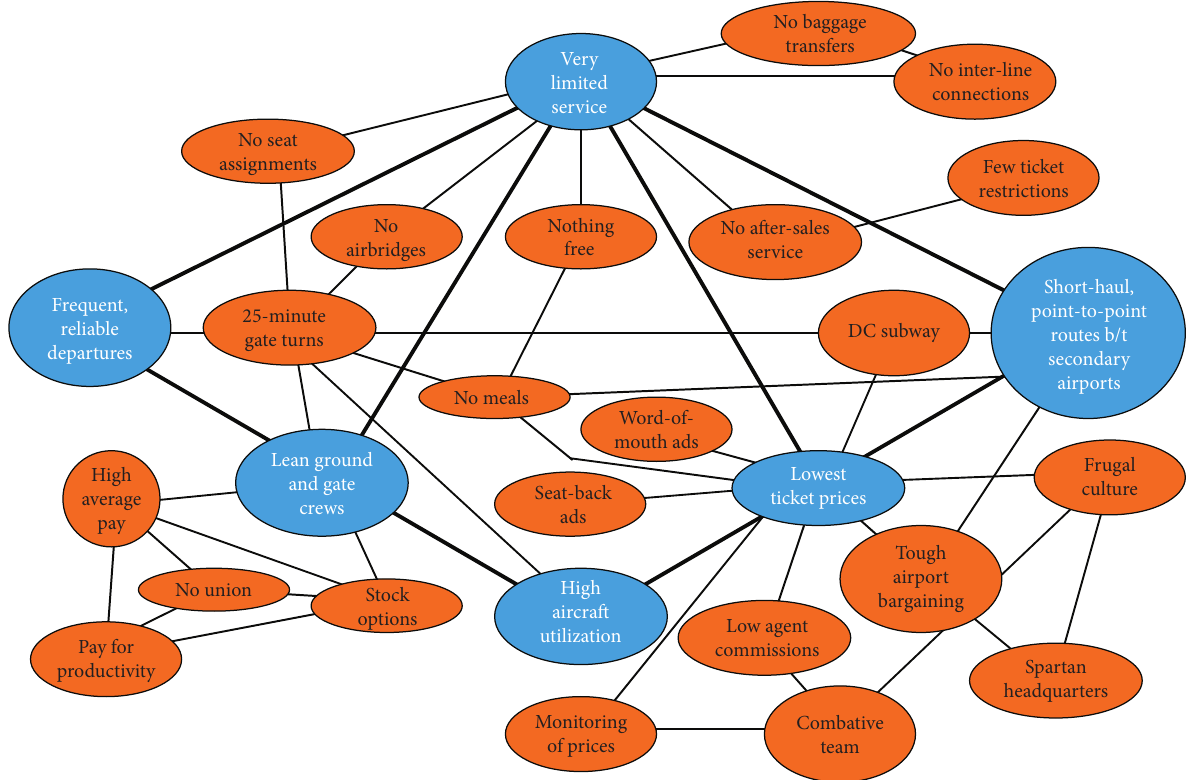
Figure 3: Schematic diagram of the DC bus wiring methods. The connection is shown between the lines.